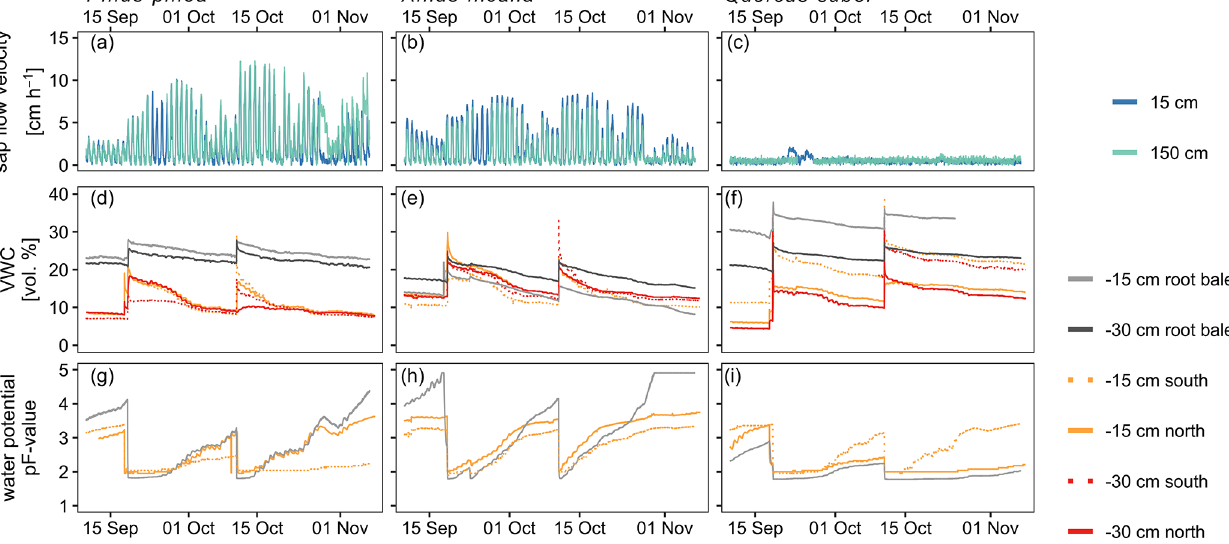
Figure 4. Soil-, tree- and atmospheric conditions over the course of the experiment in 10min temporal resolution. Soil condition and sap flow velocity is shown for the three tree pots. Sap flow velocity measurements for Quercus suber are most likely affected by sensor failures ( panel c)